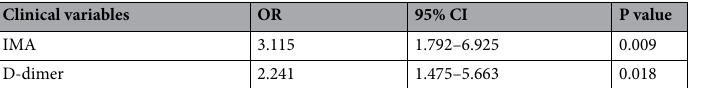
Table 6. Multivariate logistic regression analysis of the different variables associated with in-hospital mortality in TBAD. TBAD, Stanford type B aortic dissection; IMA, ischemic modified albumin; OR, odds ratio; CI, confidence interval.